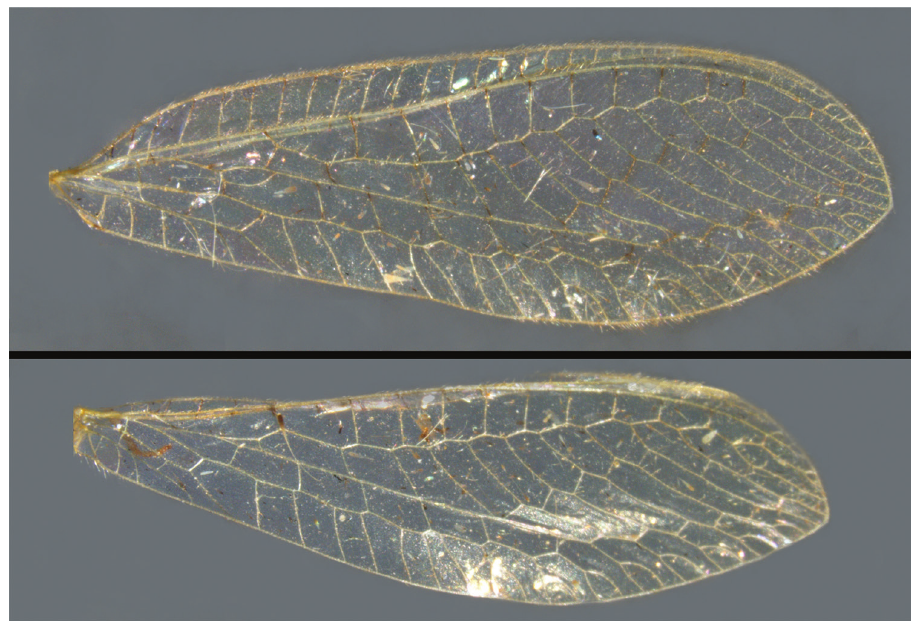
Figure 49. Chrysopa laufferi Navás: Right wings (Colombia, no locality, holotype, sex unknown, MNHN).